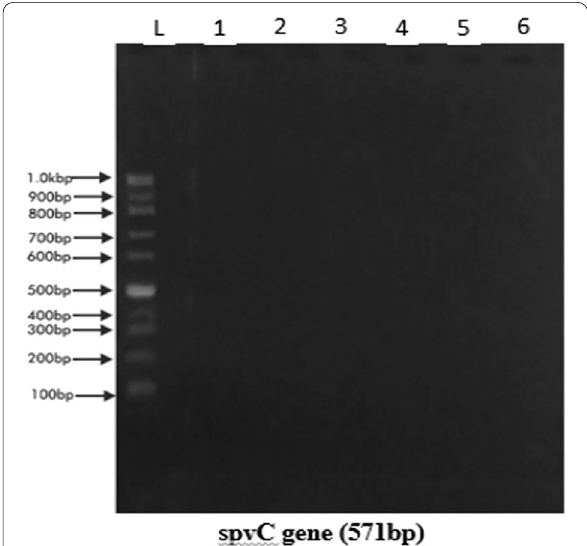
Fig. 5 PCR amplification of genomic DNA targeted to amplify the spvC virulence factor embedded in Salmonella enterica serovar typhimurium on 1.0% agarose gel electrophoresis. L Molecular = Marker. 1 A1, 2 A6, 3 A8, 4 IK2, 5 IK3, 6 = = = = = =